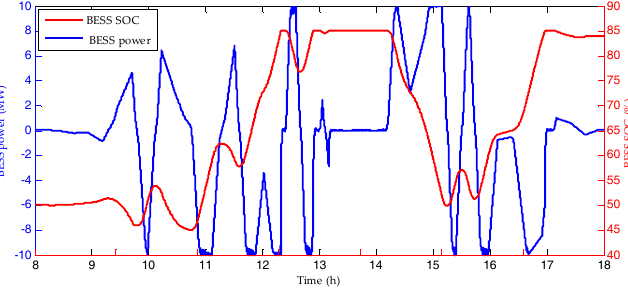
Figure 9. The charge-discharge power curve and state of charge (SOC) of the BESS.